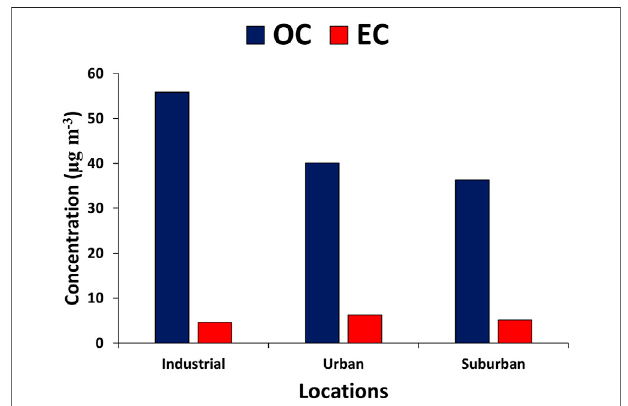
FIGURE 7 | Concentration of OC and EC in three locations of the study